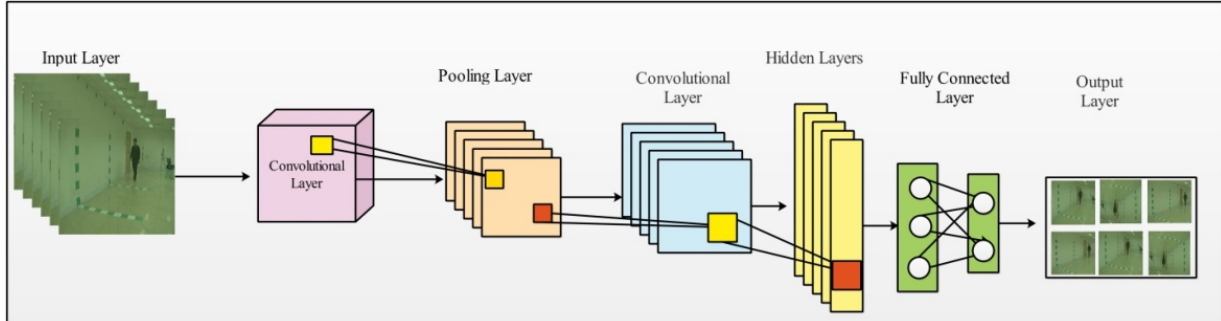
Figure 4. Convolutional neural network for the classification task.